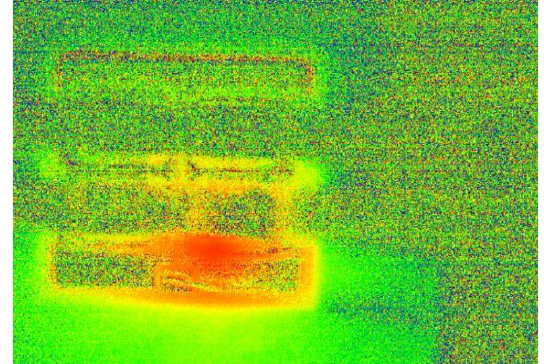
Fig. 6 . Phase image MOSFET transistor without thermal